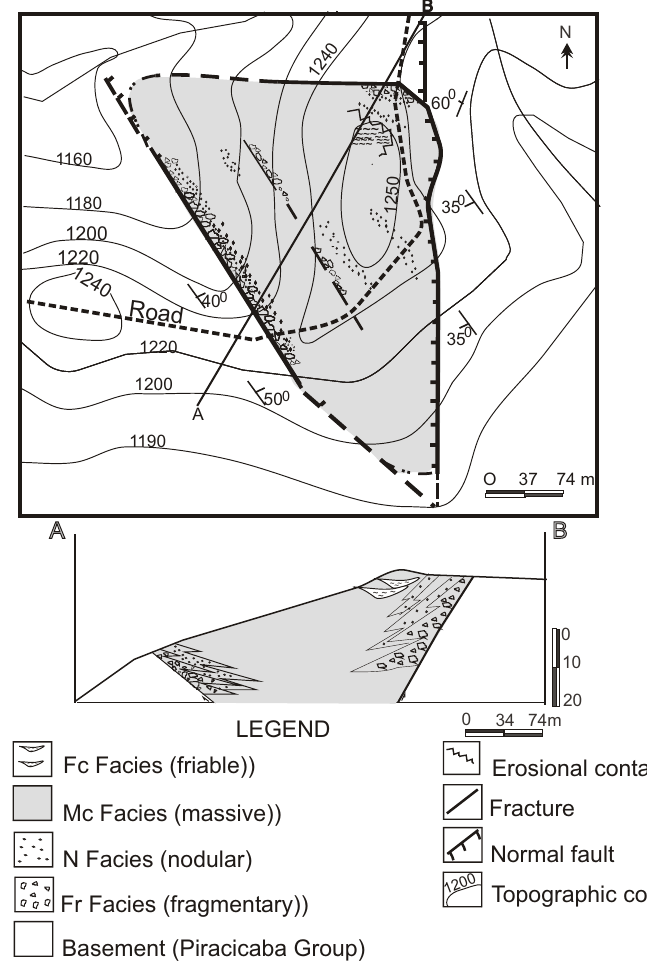
Fig. 2 – Geologic map of the Caxambu hill deposit and the schematic section AB showing the distribution of the